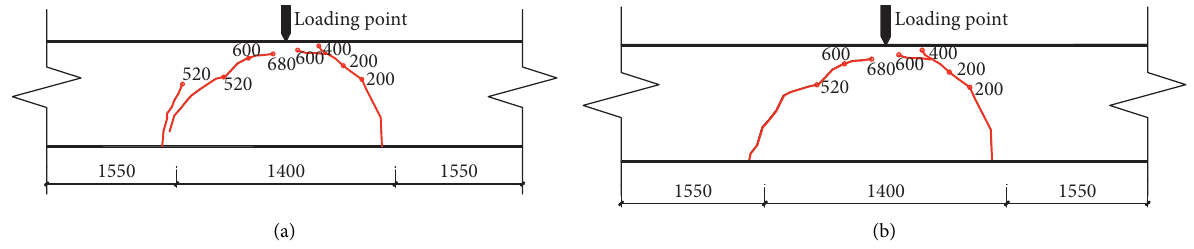
Figure 17: Crack distribution of SC-P5. (a) Crack distribution on Side A and (b) crack distribution on Side B. Table 4: Main results of the out-of-plane loading tests on steel plate-concrete slabs. Specimen no.